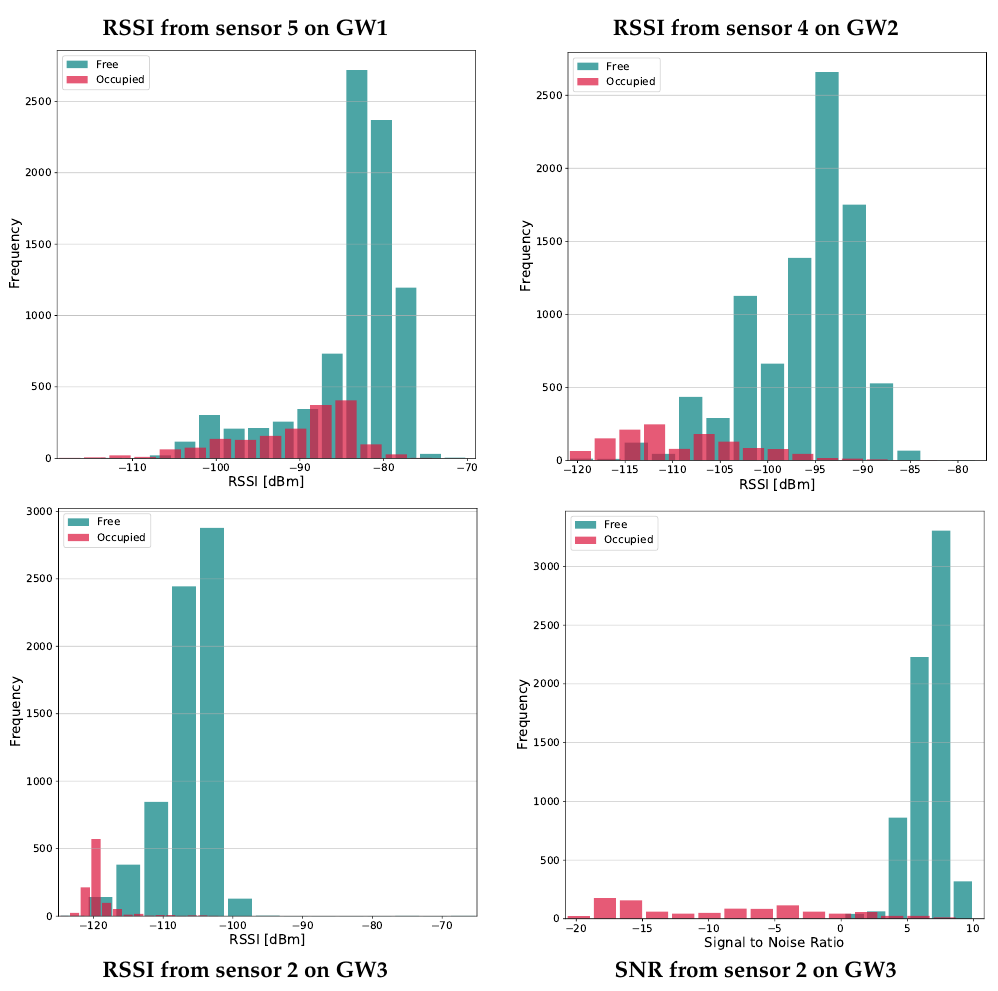
Figure 6. Histograms of RSSI and SNR values changes for different parking status and sensors from GW1, GW2 and GW3,